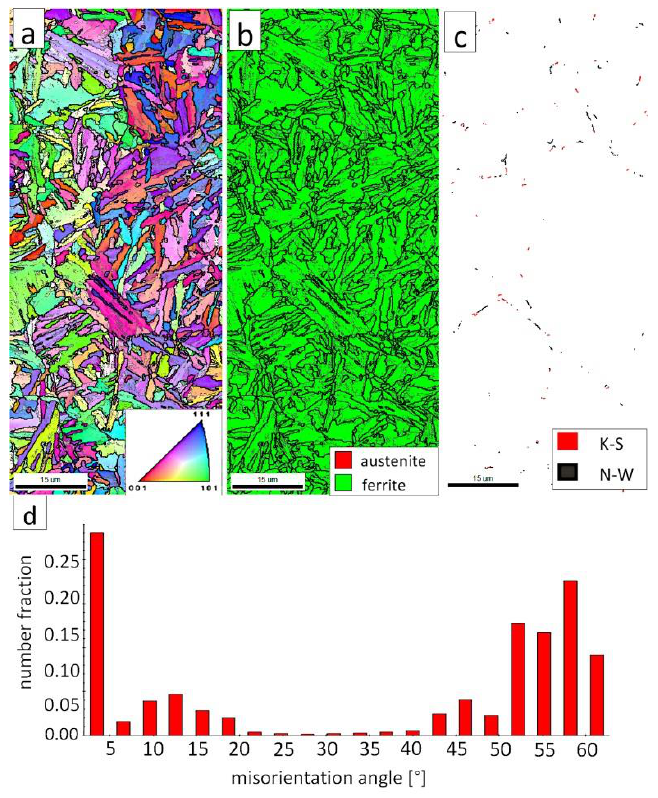
Figure 14. ( a ) IPF Map of the LTHAZ. ( b ) Phase Distribution Map of the LTHAZ. ( c ) Phase distribution map with indicated boundaries of N-W (marked in black) and K-S (marked in red) orientations. Ferrite-white, austenite-gray. ( d ) Misorientation angles distribution of the LTHAZ.